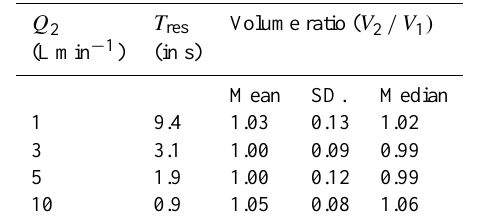
Table A1. Ratio V 2 /V 1 between the remaining volumes as a func- tion of the sampling flow through thermodenuder 2. The minimum residence time T res of the air sample in the heating unit is indicated in s.